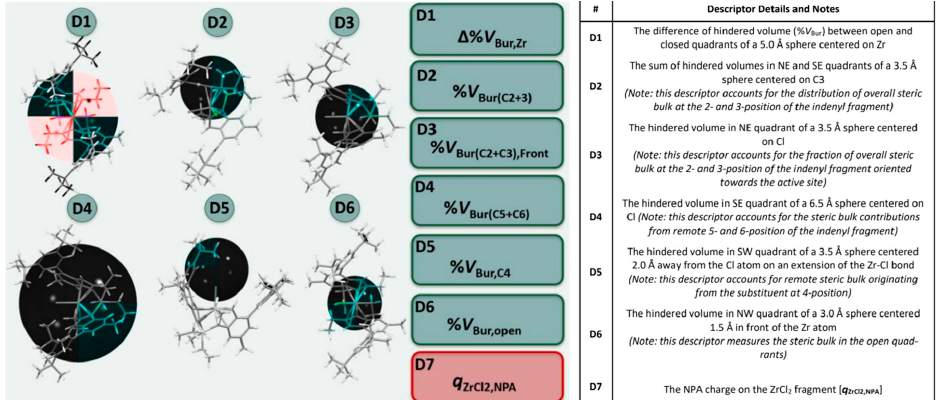
Figure 4. Computational descriptor pool for the ansa -zirconocenes of interest. 3D-steric descriptors D1–D6 were calculated using Cavallo’s SambVca 2.0 program. [84] Sphere position and size shown (black sphere), only quadrants with colored backbone are used for descriptor determination, all other quadrants are greyed out. D1–D4 and D6 shown so that the colored quadrant matches the description in the table. D5 has been rotated for clarity. (see SI, Tables S4 and S5 details on coordinate system definitions and construction of spheres and for further